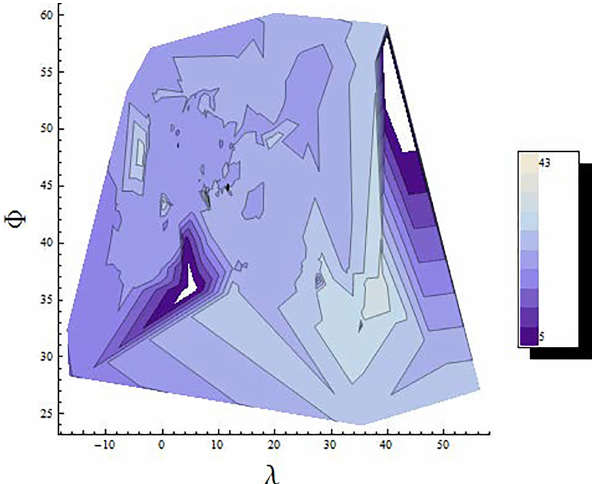
Figure 11. Longitude difference plot for each location set. The axes are contemporary latitude and